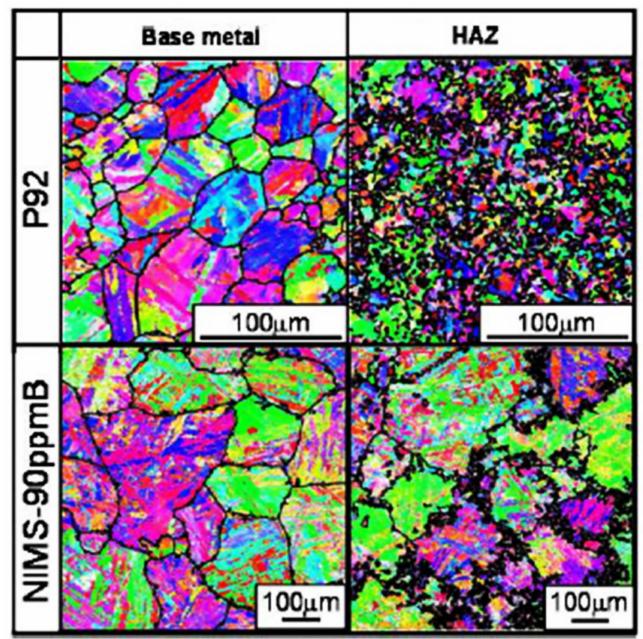
Figure 3. Comparison of grain size in base metals and HAZs of conventional martensitic steel P92 and NIMS 130B 9Cr–3W–3Co steel, using electron backscatter di ff raction (ESBD)